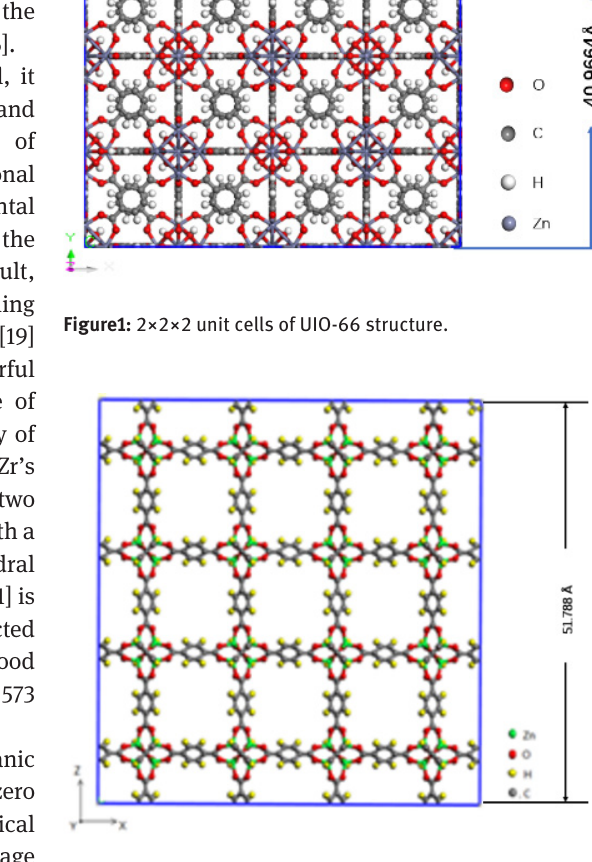
Figure 2: 2×2×2 unit cells of MOF-5